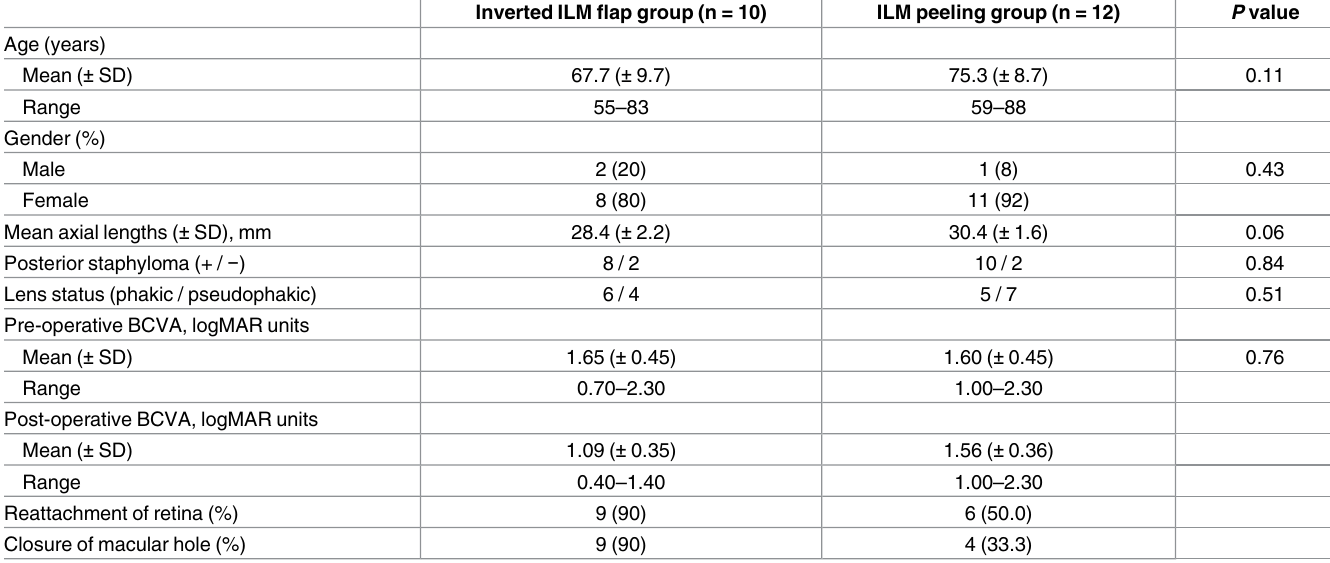
Table 1. Demographic data of the patients underwent vitrectomy for macular hole with retinal detachment.